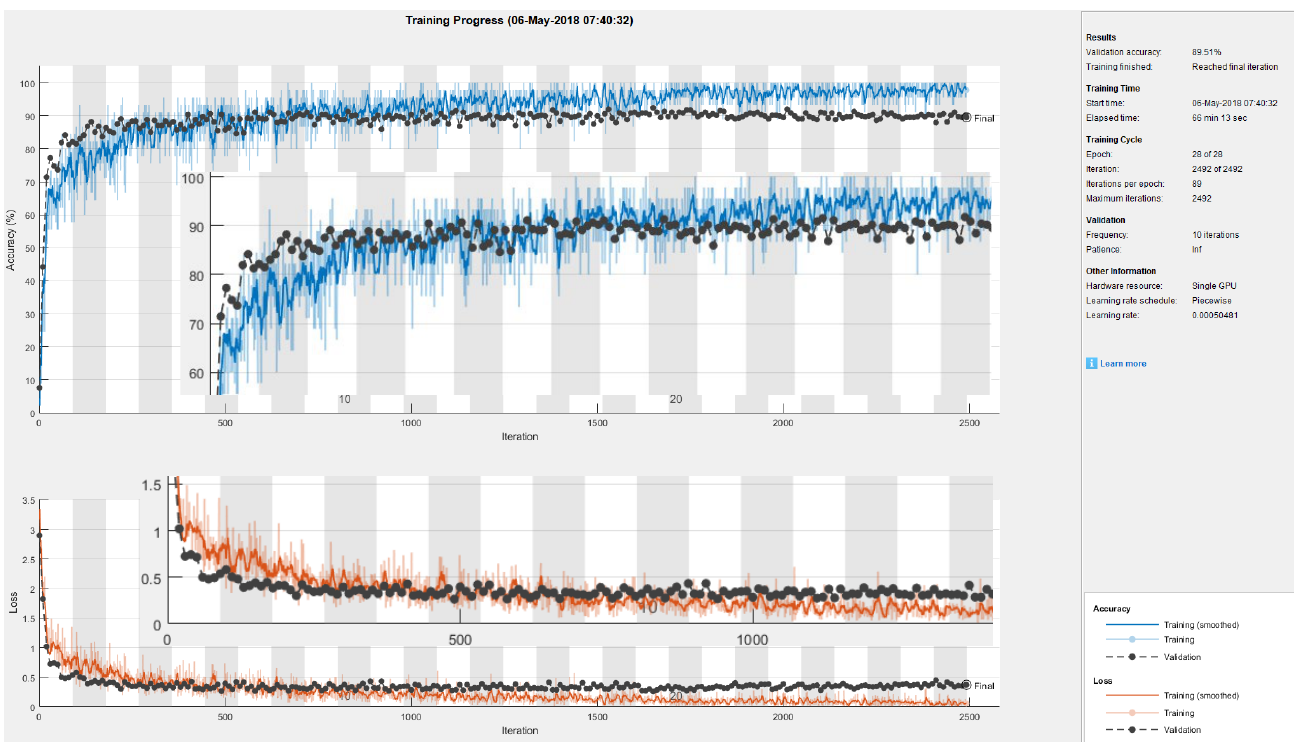
Fig. 6. A screenshot of the training process progress for regular TLCNNs. The training loses after the 11 th epoch. The TLCNN size is approximately 202.6 MB.